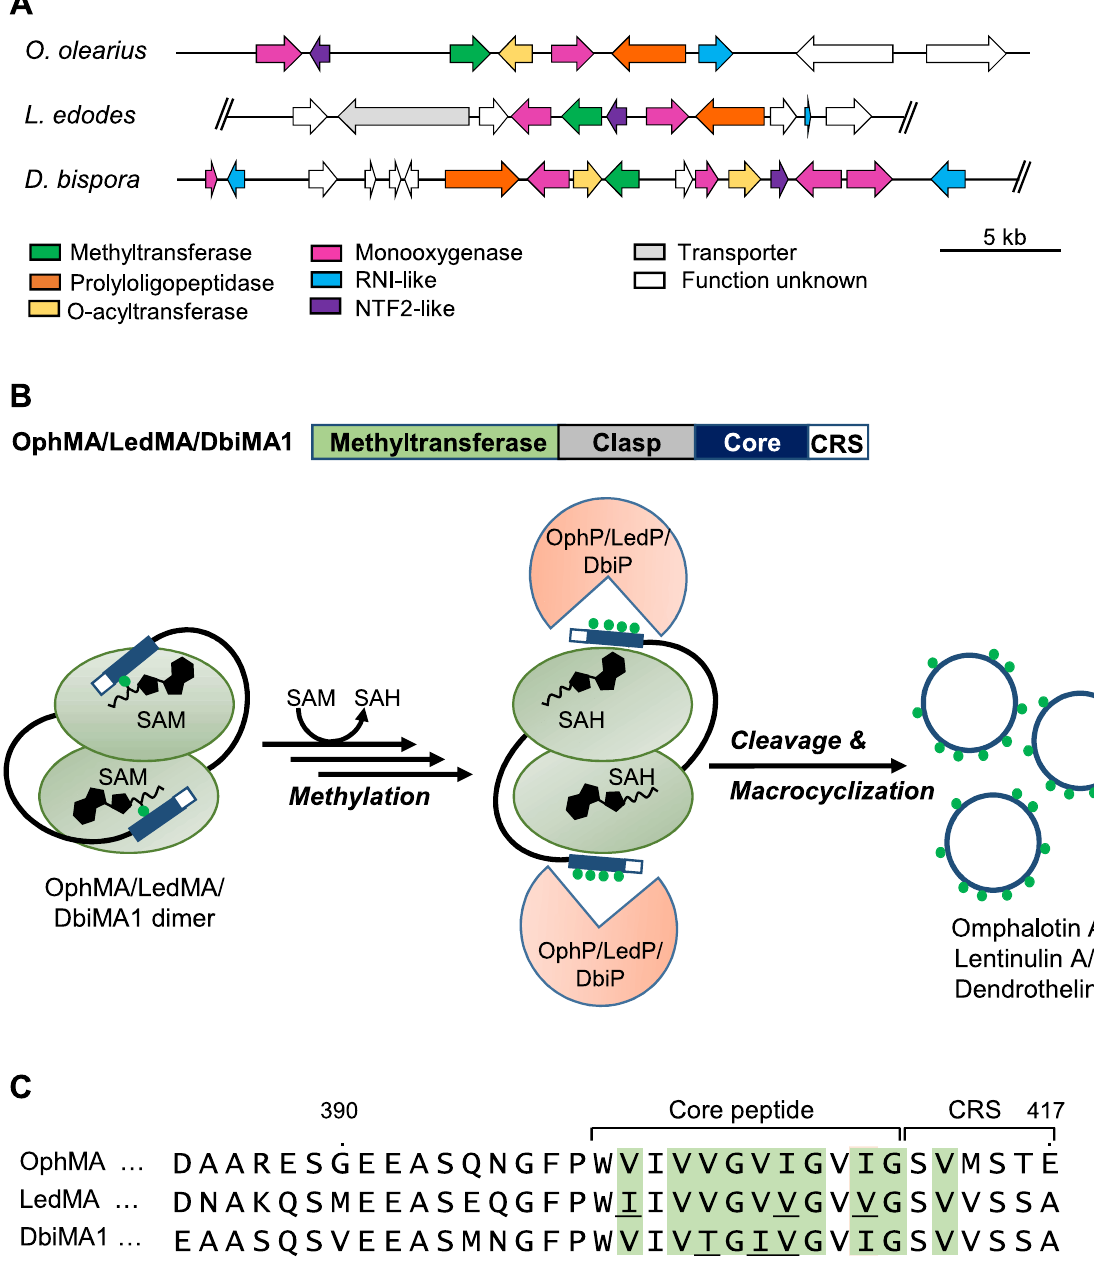
Figure 1. Structure and function of omphalotin biosynthetic gene cluster and homologous clusters in the basidiomycetes O. olearius , D. bispora and L. edodes . ( A ) Schematic representation of the borosin biosynthetic gene clusters in the basidiomycetes O. olearius (VT 653.13, scaffold_169), L. edodes (Le(Bin) 0899 ss11, scaffold_10) and D. bispora (CBS 962.96, scaffold_621). All three clusters code for a precursor (methyltransferase) protein, referred to as OphMA, LedMA and DbiMA1 respectively, and a prolyloligopeptidase, referred to as OphP, LedP and DbiP, respectively. The DNA scaffolds and filtered gene models were taken from https:// mycoc osm. jgi. doe. gov/. Double slashes (//) indicate that the sequence of the DNA scaffold continues beyond this position. ( B ) Biosynthesis scheme of omphalotin A and closely related peptides, lentinulin A and dendrothelin A as a combined action of the precursor (methyltransferase) protein and the prolyloligopeptidase. ( C ) Alignment of the C-termini of the precursor (methyltransferase) proteins from O. olearius (OphMA), L. edodes (LedMA) and D. bispora (DbiMA1). Residues differing from the omphalotin core peptide are shown in red. The indicated methylation patterns (green fill) were previously determined by heterologous expression of the respective cDNAs in E. coli 21,23,25 . CRS = C-terminal recognition